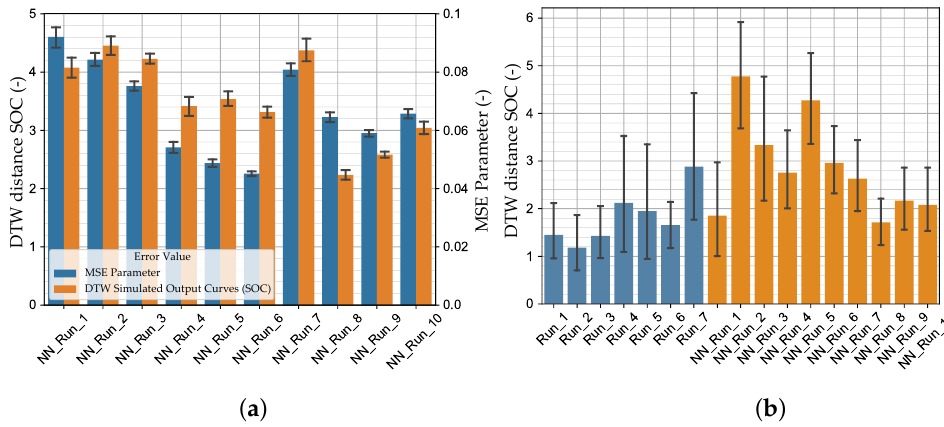
Figure 12. Comparison of the distance measures of ( a ) the NN-based method for the validation dataset and ( b ) the optimization-based and the NN-based method for the virtual experimental